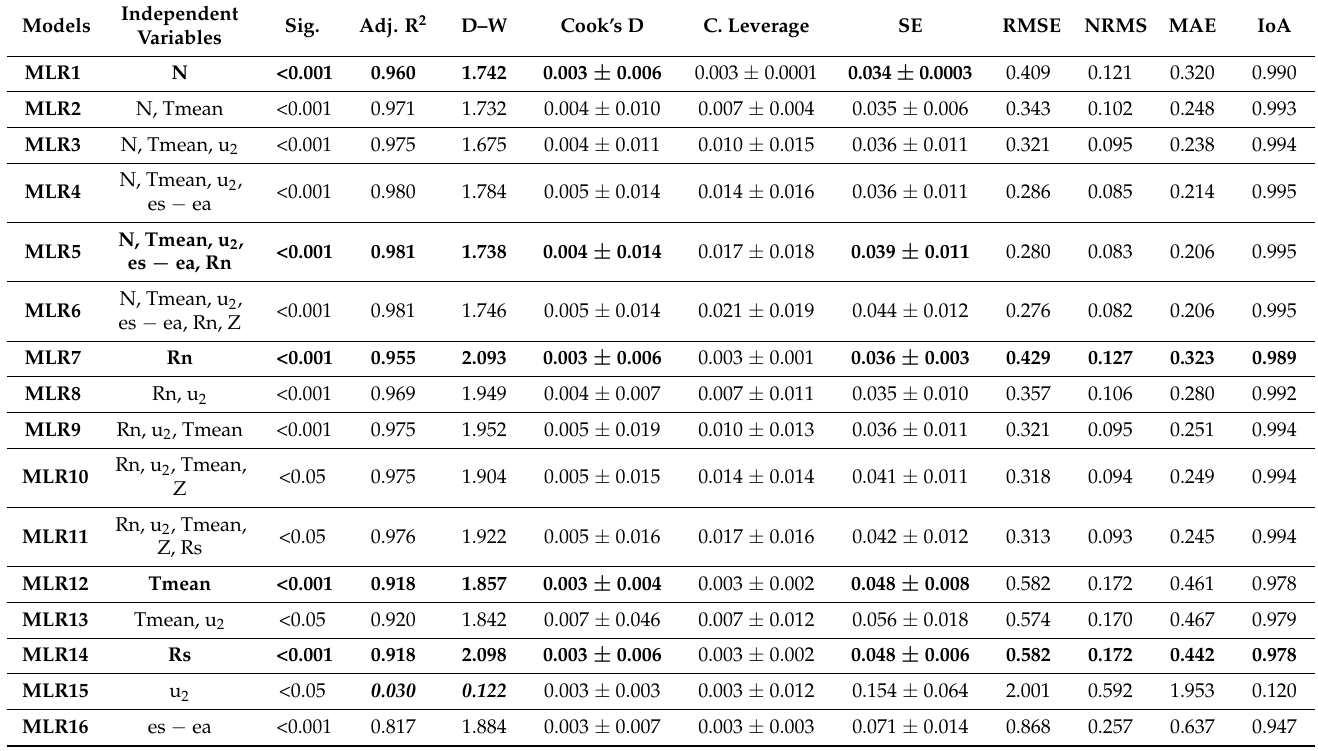
Table 2. The 16 regression models and the corresponding indices of performance.